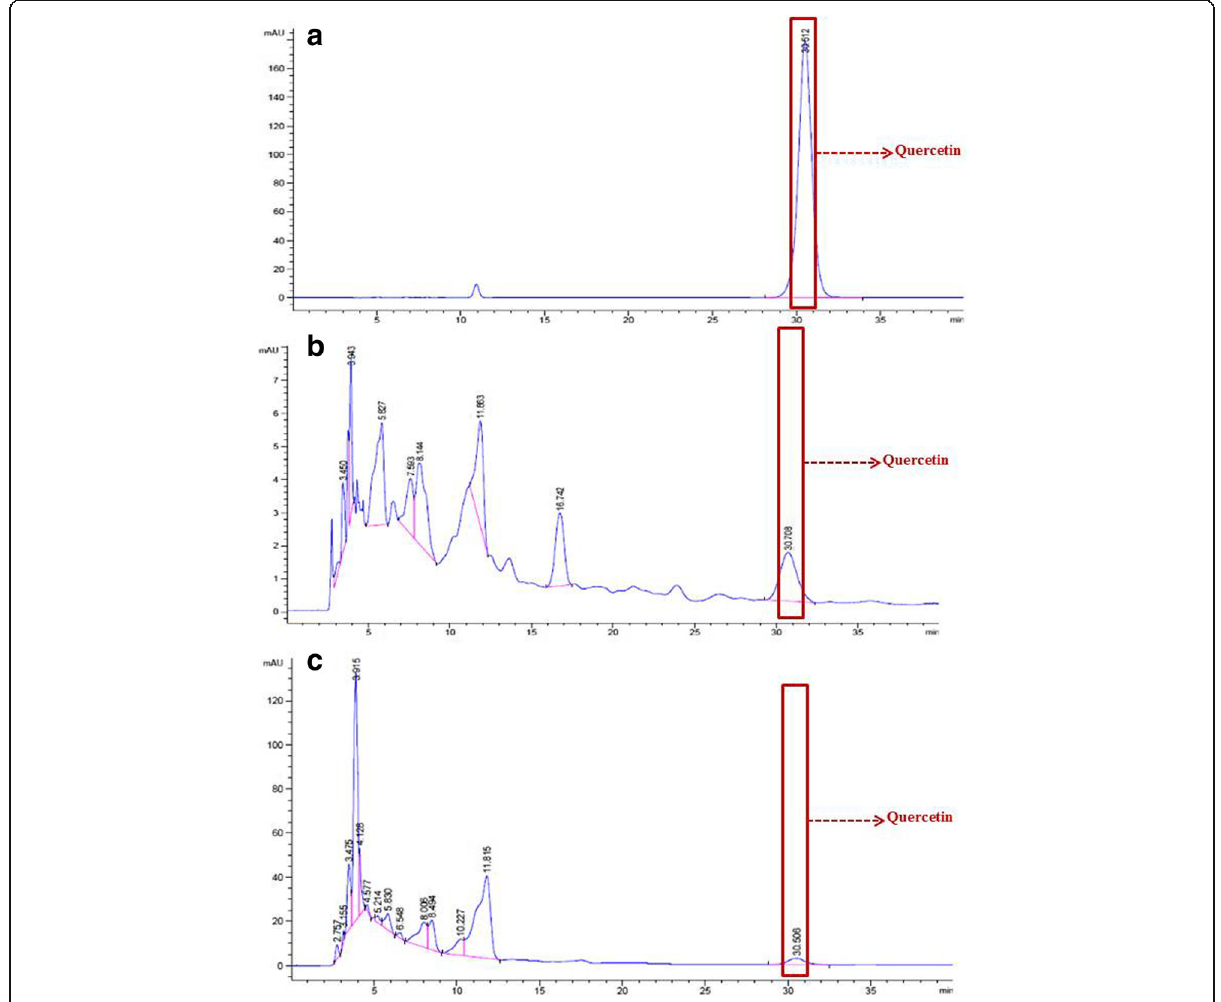
Fig. 4 HPLC chromatogram of quercetin a , crude extracts of Uvaria longipes b and Marsypopetalum modestum c . Arrows show the peaks corresponding to the standard